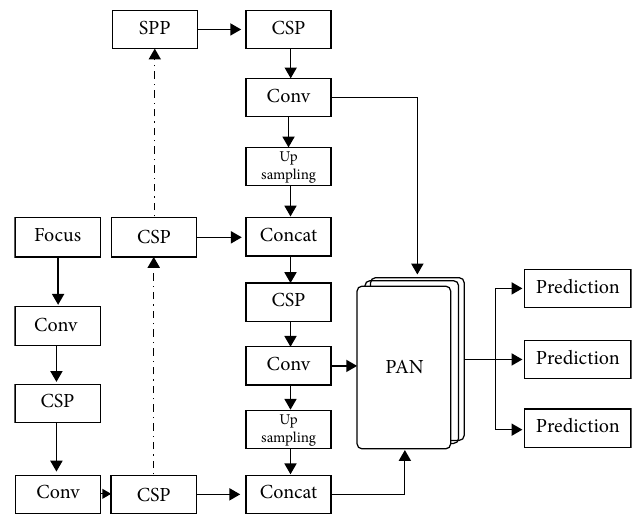
Figure 1: Yolov5 network structure.